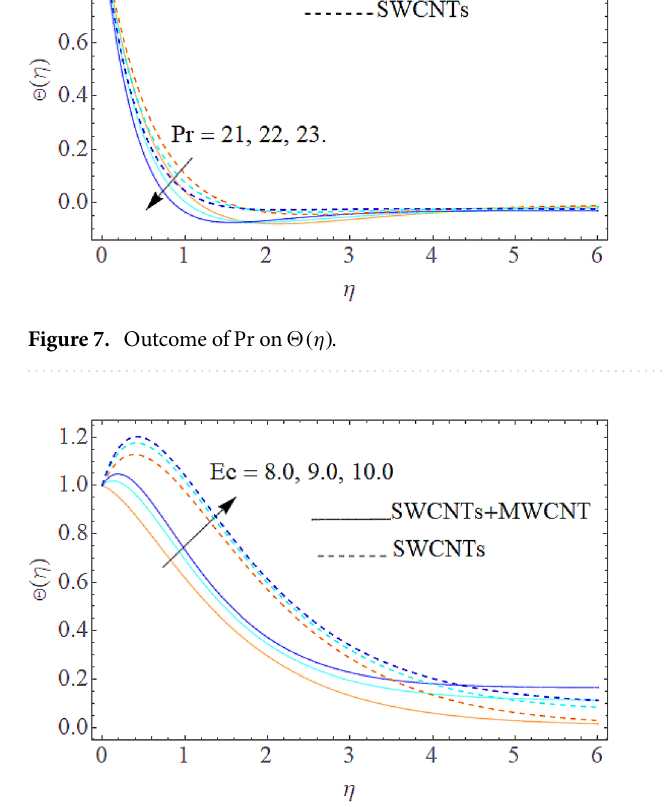
Figure 8. Impact of Ec on �(η) .